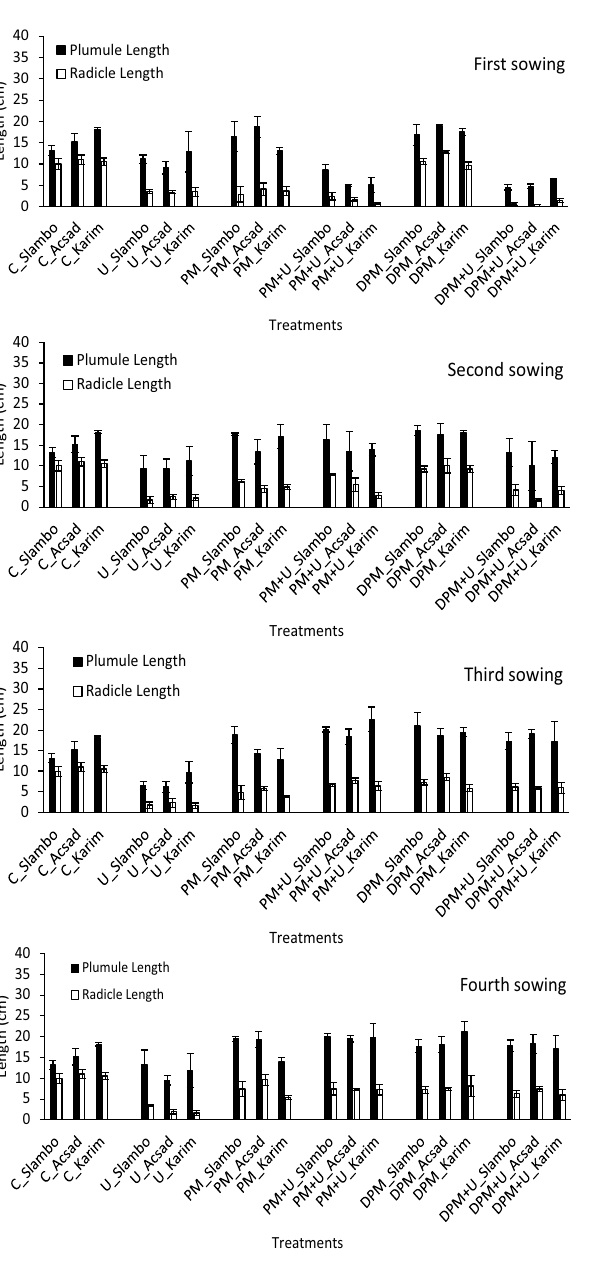
Fig. 2 Seedling dry weight of three wheat cultivars ( Slambo , Acsad and Karim ) after 14 days growing period sown in desert soil on four sowing dates after amendment with non-digested and anaerobically digested poultry manure with and without combination with urea. Bars represent mean ± standard deviation ( n =